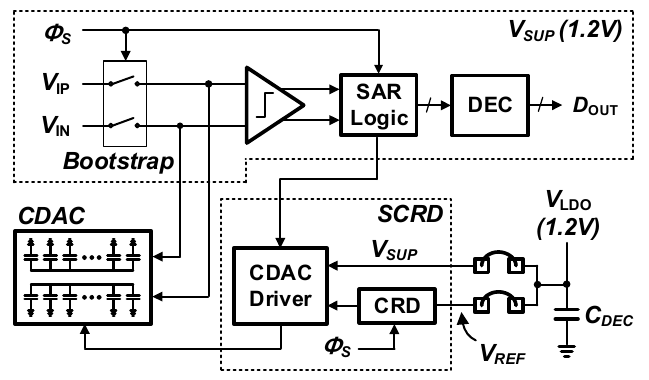
Figure 9. The block diagram of the SAR ADC with the proposed SCRD.